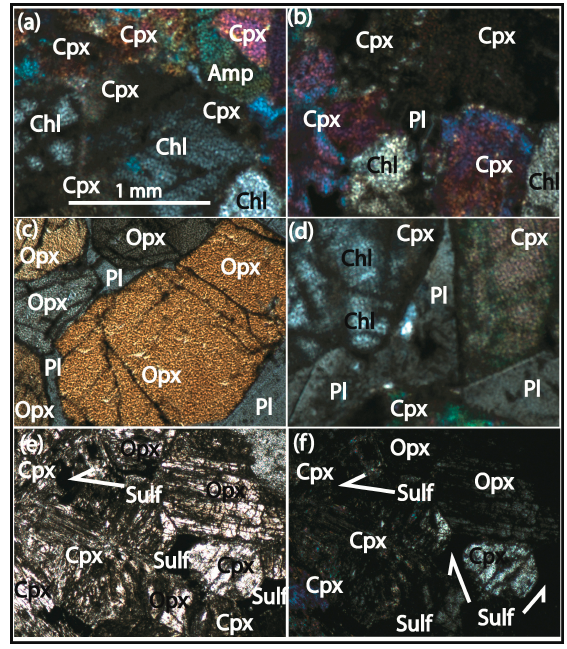
Figure 6. Scale bar shown in ( a ) is the same for all photomicrographs. ( a,b ) Photomicrographs showing numerous alteration minerals of chlorite (Chl) and amphibole (Amp) occurring with relict cumulus clinopyroxene (Cpx) and relict intercumulus plagioclase (Pl) under crossed polars (sample MusWebb01). Most of the crystals in ( a , b ) are fine- to medium-grained. ( c ) Sample MusPxHw01 under crossed polars showing coarse-grained euhedral to subhedral cumulus orthopyroxene (Opx) enclosed by poikilitic plagioclase. In ( d ), euhedral to subhedral clinopyroxene crystals occurs within poikilitic plagioclase, with the clinopyroxene altering to chlorite, crossed polars, sample MusPeg01; note the different scale bar in ( d ). ( e )—plane polarized light and ( f ) crossed polars: Sulfides (Sulf) occurring both within and as intercumulus phases both clinopyroxene and orthopyroxene crystals. The pyroxenes have been altered. Crossed polars, sample BMSZ01. Within the pegmatoidal plagioclase pyroxenite, which occur stratigraphically below the plagioclase websterite, coarse-grained and euhedral to subhedral cumulus orthopyroxene crystals are enclosed by poikilitic plagioclase crystals (Figure 6c; sample MusPxHw01). Orthopyroxene is the dominant cumulus phase, and no alteration minerals were observed within the pegmatoidal plagioclase pyroxenite. However, just below the pegmatoidal plagioclase pyroxenite, both chlorite and amphibole occur together. Here, euhedral to subhedral clinopyroxene crystals occur within poikilitic plagioclase, with crystals of clinopyroxene altering to chlorite crystals (Figure 6d; sample MusPeg01). Occurring stratigraphically below the pegmatoidal plagioclase pyroxenite is plagioclase pyroxenite, and a base metal sulfide zone is located within this plagioclase pyroxenite. Within the